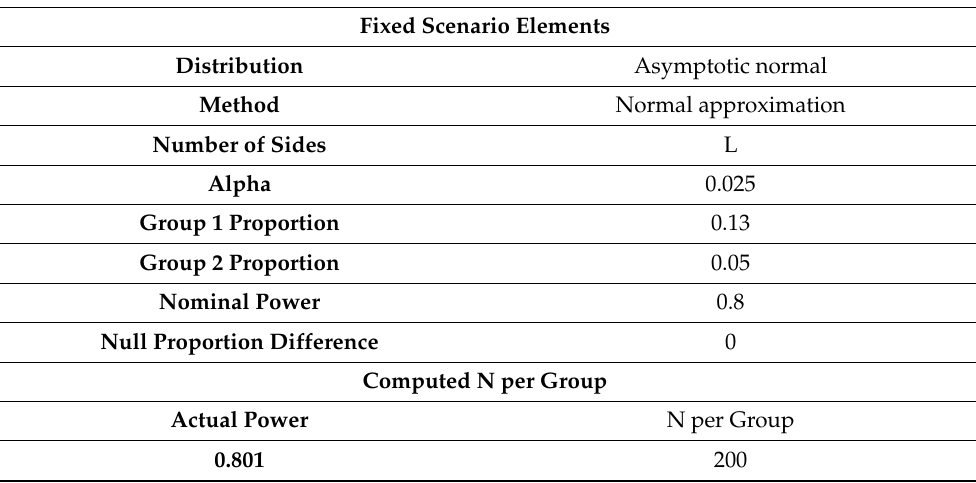
Table A1. The POWER